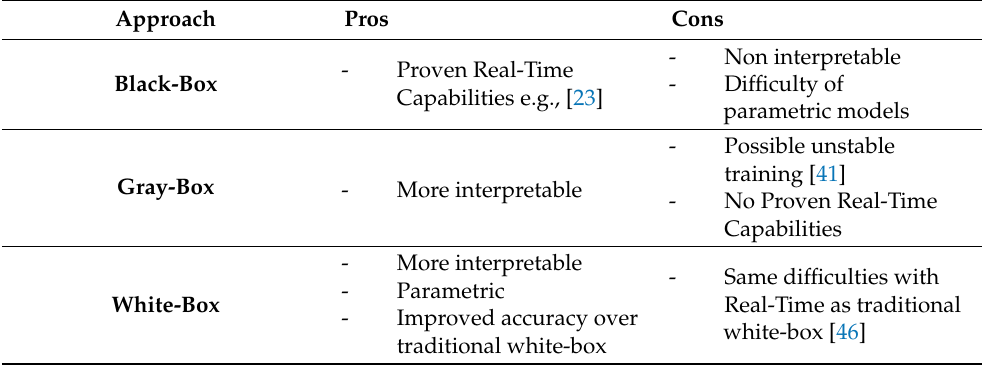
Table 3. Summary of the modelling approaches that utilize deep learning as well as their advantages and